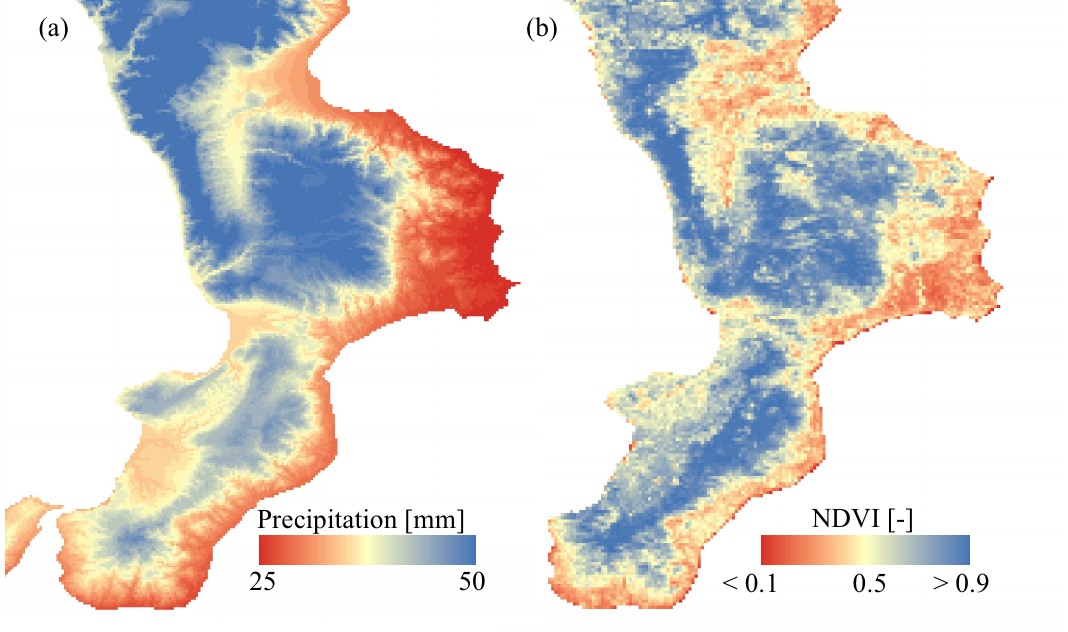
Figure 4. ( a ) Total precipitation for the month of May in the WorldClim [14] dataset. ( b ) Multiyear averaged MODIS NDVI for the month of July.